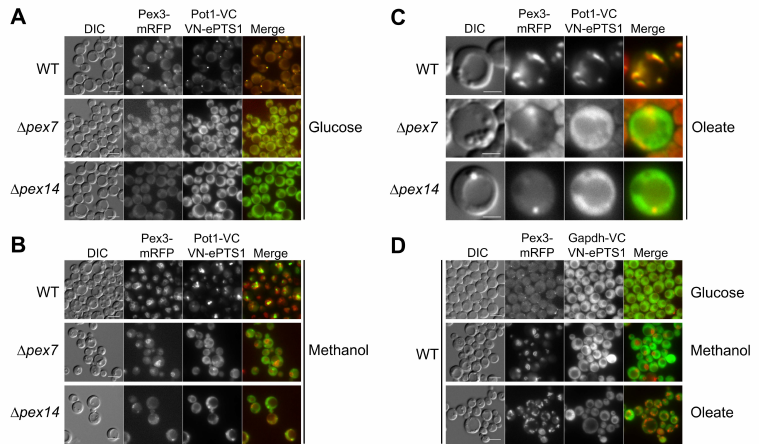
Figure 3. Feasibility of the divergent BiFC assay using known peroxisomal matrix and cytosolic proteins. The PTS2-containing protein, thiolase (Pot1), was fused to VC (Pot1-VC), and the PTS1 was fused to VN (VN-ePTS1). Strains were grown overnight in either ( A ) glucose, ( B ) methanol, or ( C ) oleate. ( D ) Strains were grown overnight in glucose, methanol, and oleate, and peroxisomal fluorescence were not observed for a cytosolic protein (Gapdh). Peroxisomes were visualized using Pex3-mRFP. Bars for ( A , B , D ) 5 µ m; bars for ( C ) 2 µ